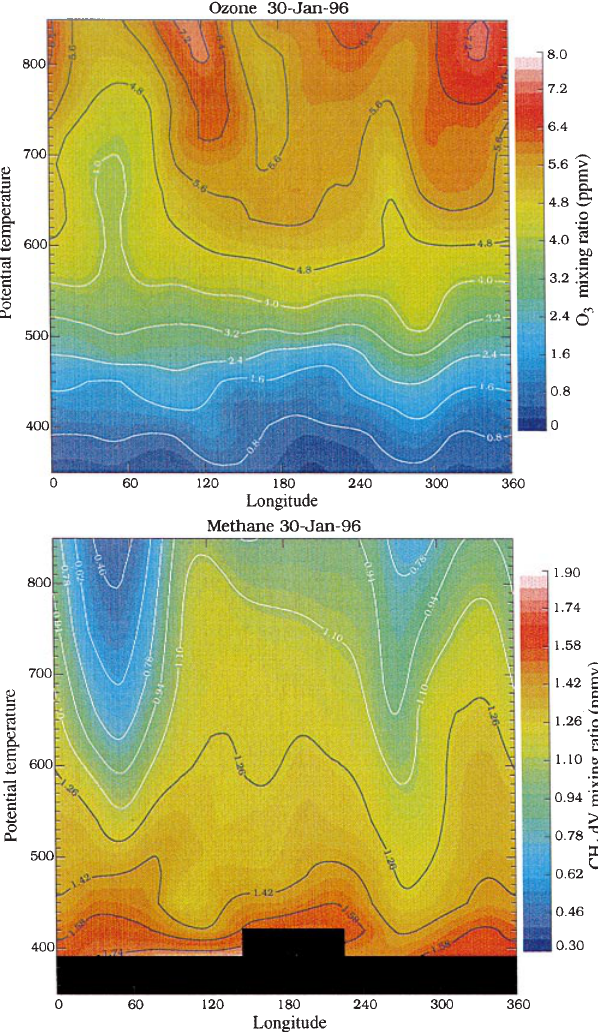
Fig. 3. As Fig. 2 but for sunset observations on January 30, 1996 (uarsday 1602), at 49 (cid:14) N. Vortex air is discernible over the whole altitude range at 267 (cid:14) E